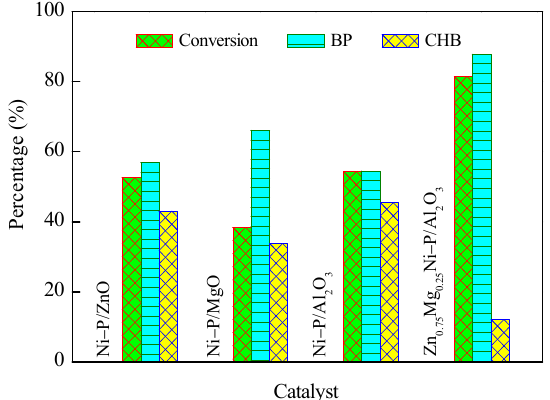
Figure 7. HDS of DBT over different catalysts, T = 653 K, P = 3 MPa, WHSV = 2.0 h − 1 and H 2 /oil ratio = 500 ( V / V ).